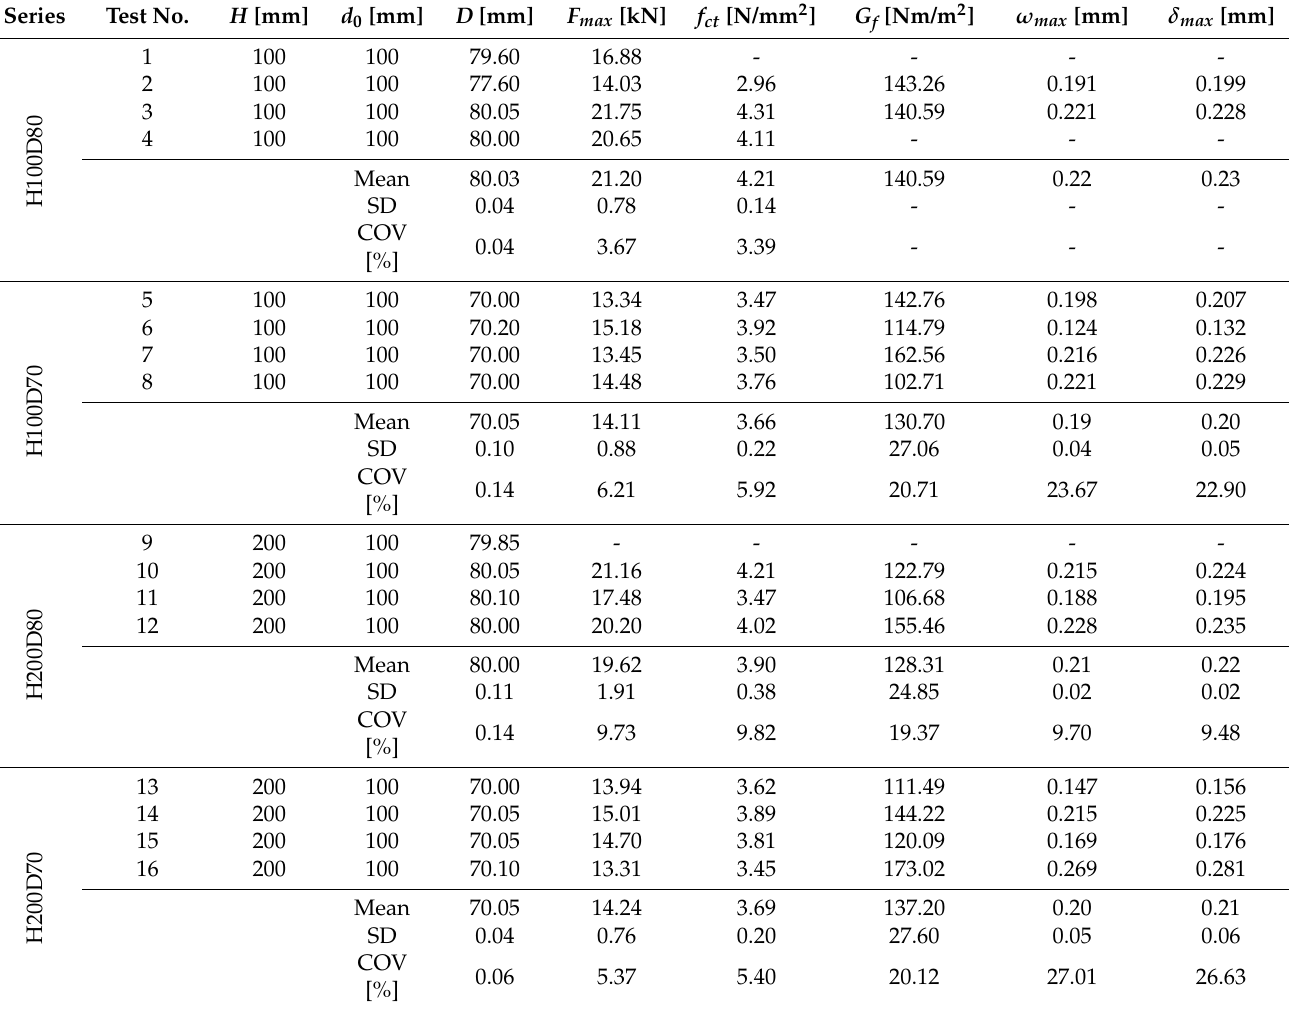
Table 5. Test results of direct uniaxial tensile load tests of 16 concrete